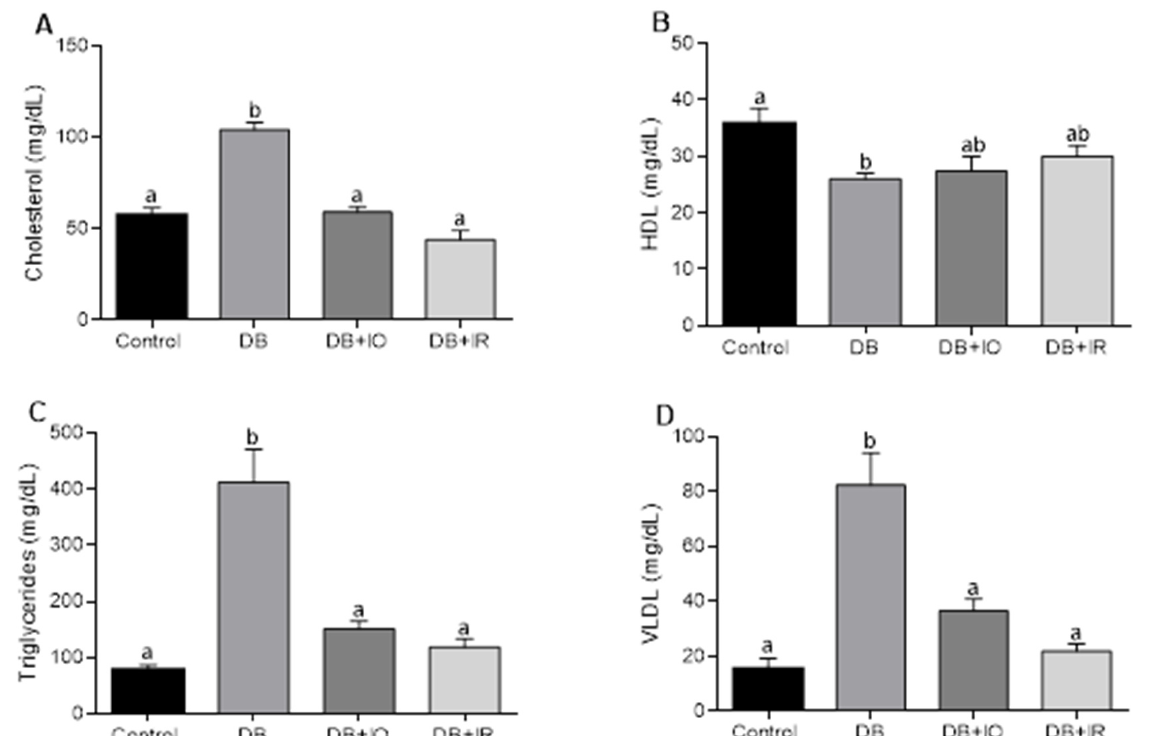
Figure 4. Serum levels of cholesterol ( A ), high-density lipoproteins (HDL) ( B ), triglycerides ( C ), and very-low-density lipoproteins (VLDL) ( D ). Data are presented as group mean ± standard error. p < 0.05 ( n = 6, ANOVA plus Tukey’s post hoc test). Different letters represent statistically significant differences. DB + IO, diabetic rats with iron overload; DB + IR, diabetic rats with iron restriction diet.